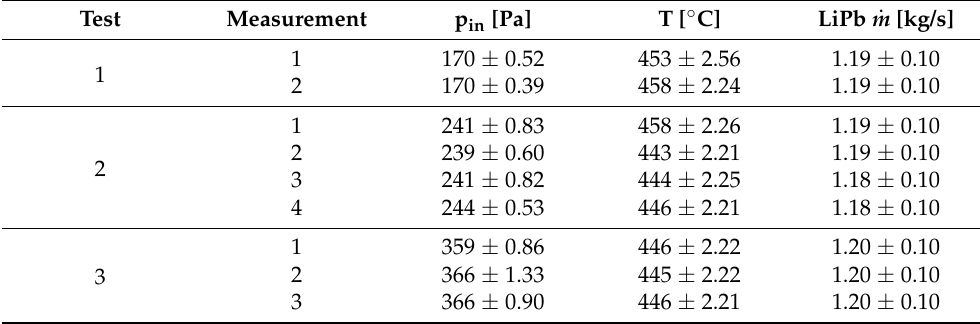
Table 1. Test matrix for the PAV experimental